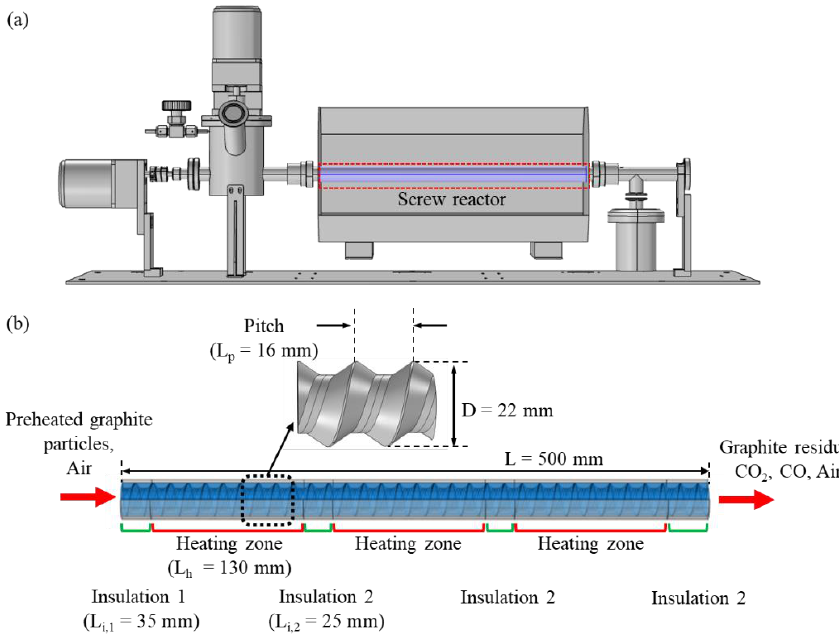
Figure 1. ( a ) Schematic diagram of the screw reactor system. ( b ) Dimensions of the screw reactor for the computational